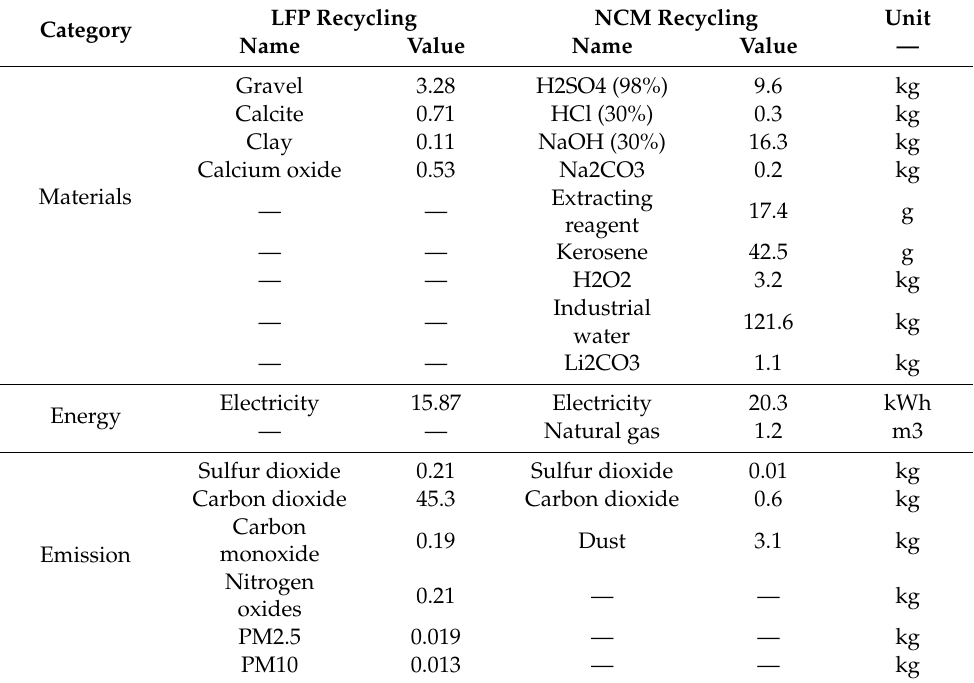
Table 6. Inventory data for the recycling of 1 kWh waste LFP battery and nickel cobalt manganese lithium (NCM) 622